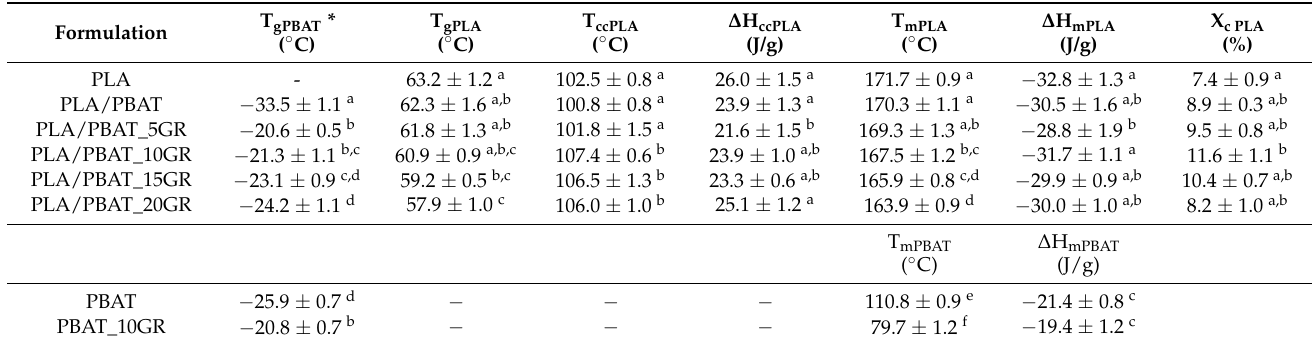
Table 4. Thermal properties of studied formulations and neat matrixes